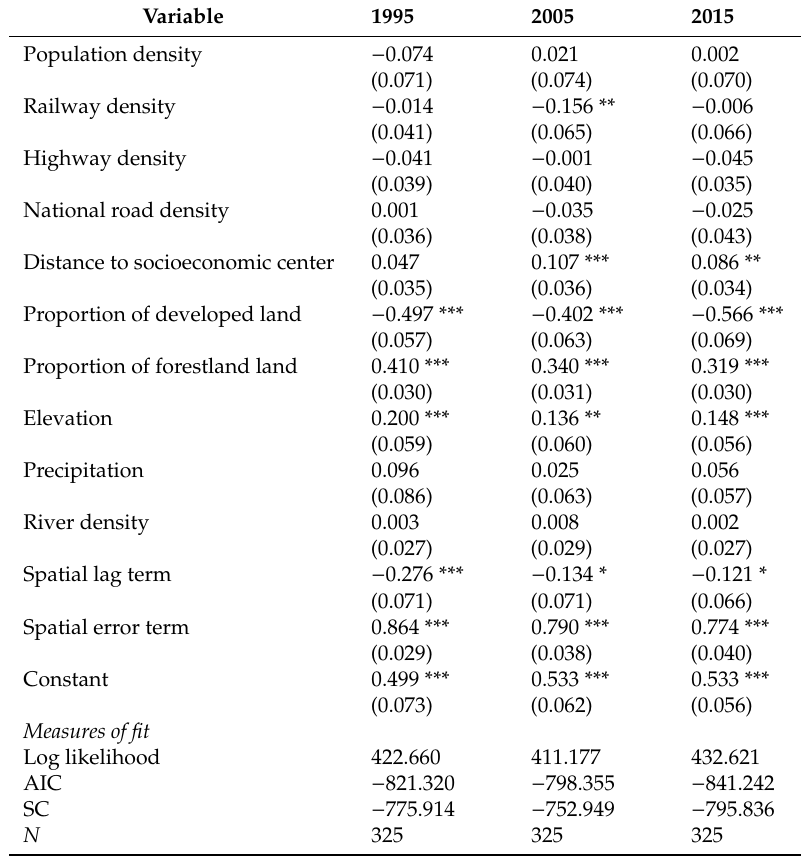
Table 6. Regression results of the spatial error models with lag dependence from 1995 to